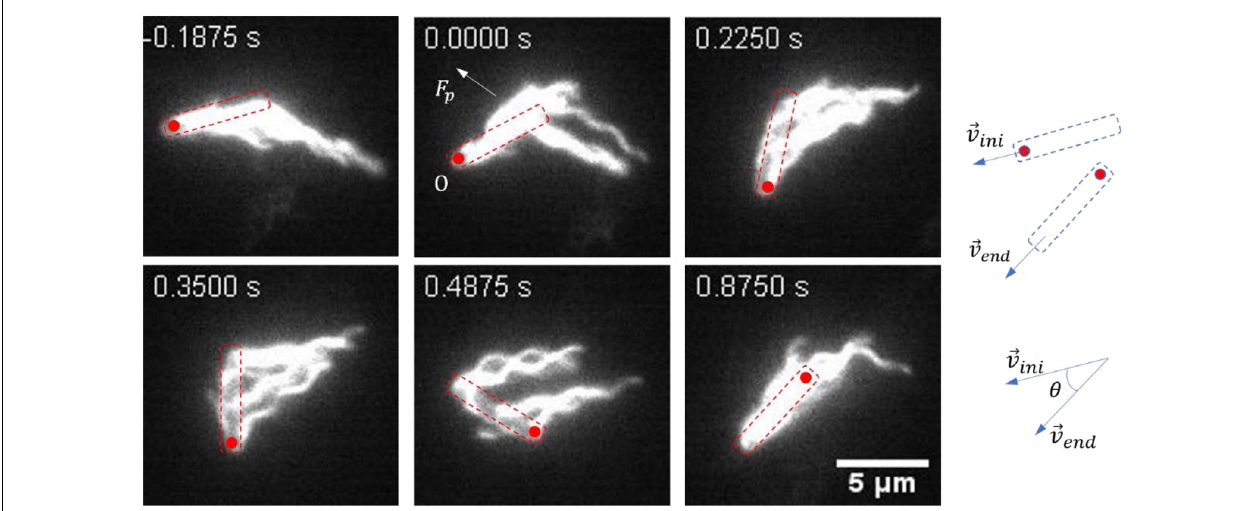
FIGURE 2 | Images sequences taken from Supplementary Movie S4 . The time stamp of each movie frame was shown. In this case, multiple flagella filaments, when rolled to the side of the cell, provided lateral force ( F p ). With the pinned head as the instantaneous fixed origin (O), F p leads to a torque on the cell body that causes it to rotate CCW about O, in order for the cell to find the suitable direction to escape (usually with a small angle change of the moving direction). The cell body is indicated by a dashed box, and the red circle marks the position of the initial head. The small change in angle is schematically shown on the right.